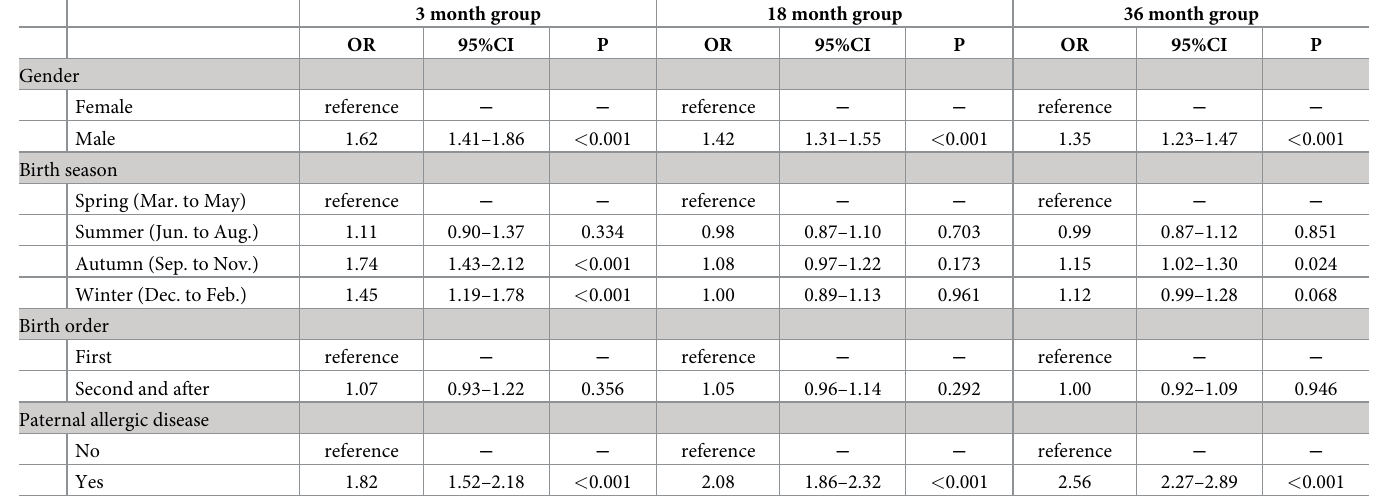
Table 4. Univariate analysis between wheeze and eczema and covariates in three age